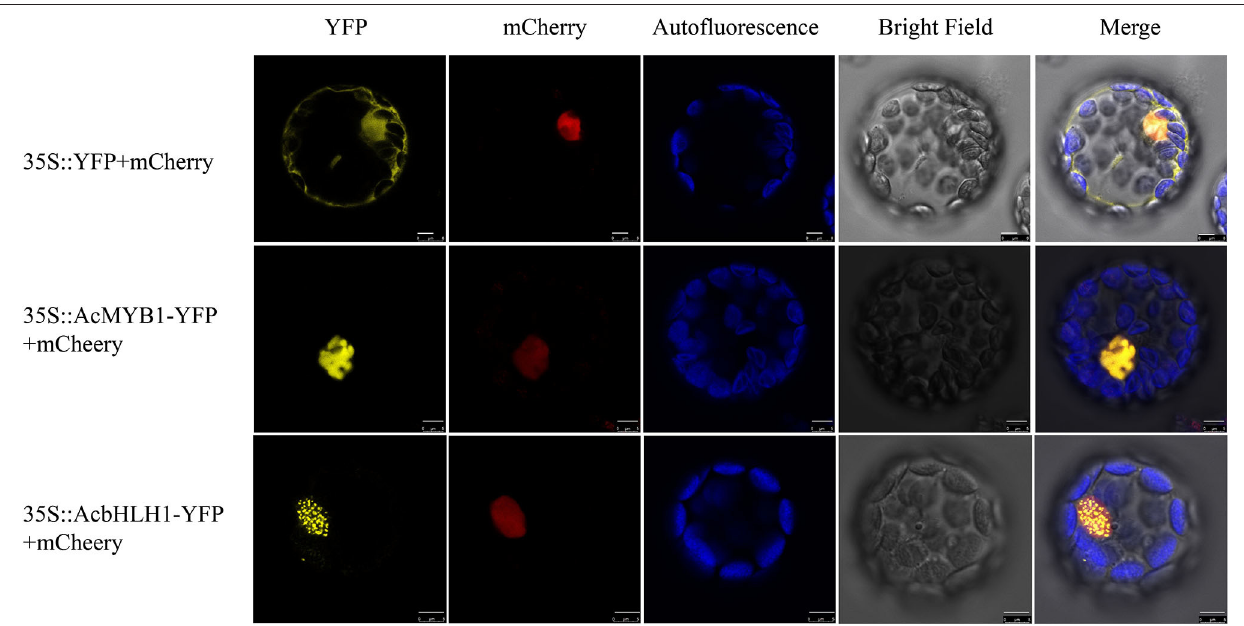
FIGURE 4 | Subcellular localization of AcMYB1 and AcbHLH1 proteins in Arabidopsis thaliana mesophyll protoplasts. Transient expression of the 35S::YFP-mCherry control, 35S::AcMYB1-YFP, and 35S::AcbHLH1-YFP, showing YFP fluorescence, mCherry nuclear localization, chlorophyll autofluorescence, bright field, and merged images. Scale bar: 5 µ m. YFP, yellow fluorescence